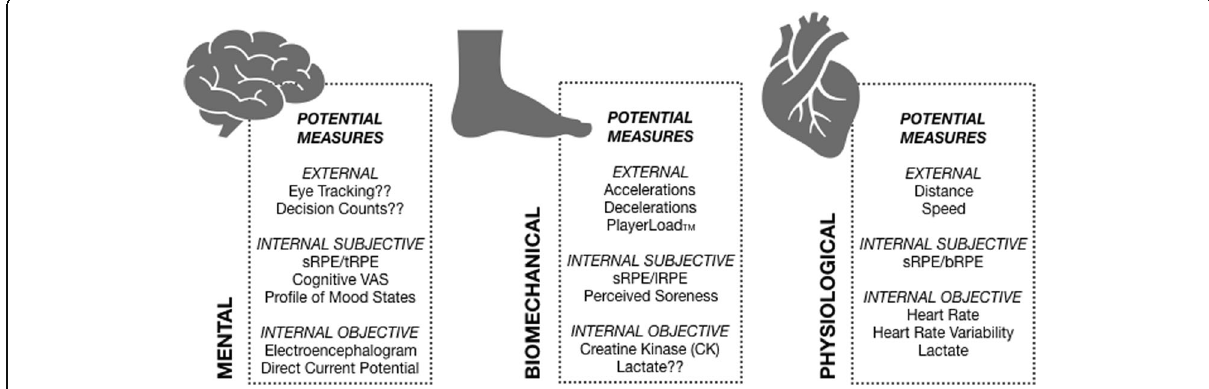
Fig. 2 Potential measures to combine with differential RPE or sRPE in a multivariate training load model that considers physiological, biomechanical, and mental load. Adapted from Vanrenterghem et al. [63]. sRPE, sessional rating of perceived exertion; tRPE, technical rating of perceived exertion; lRPE, leg muscle rating of perceived exertion; bRPE, breathe rating of perceived exertion (breathlessness); VAS, visual analogue